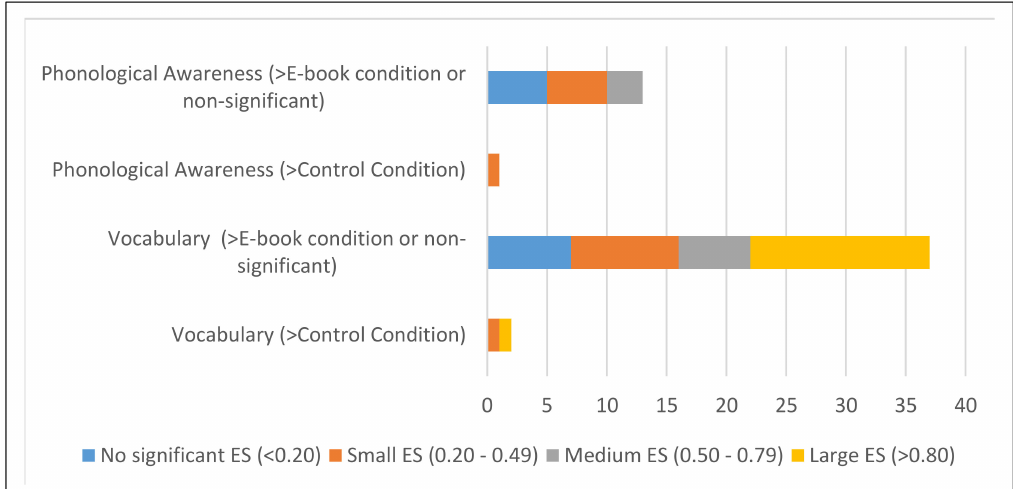
Figure 2. Summary of the frequencies of ES (effect size) in vocabulary and phonological awareness in the e-book and control